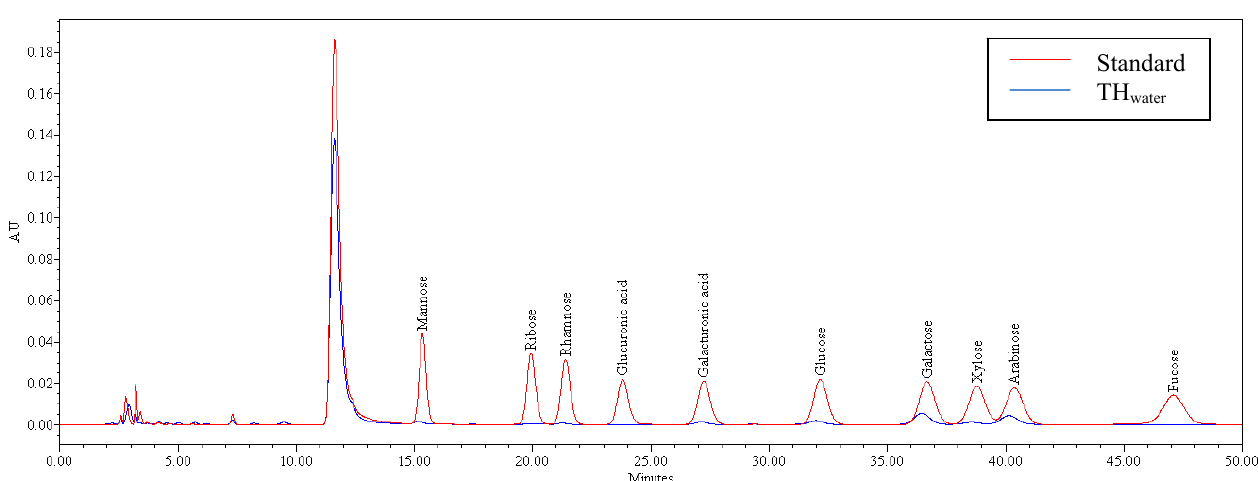
Figure 5. Chromatogram of PMP derivatives of monosaccharide standard and tamarillo hydrocolloid (TH ). water